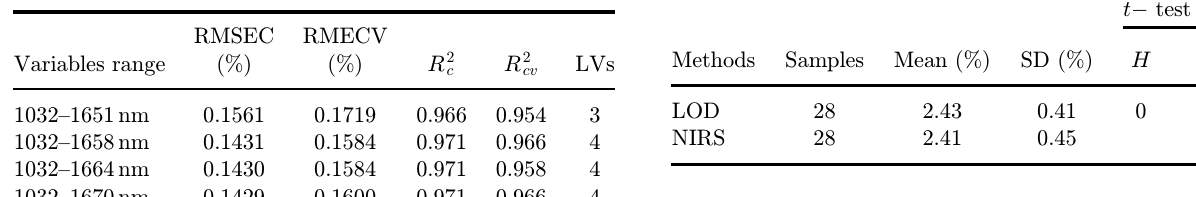
Table 3. The results of PLS models after eliminating di®erent variables.